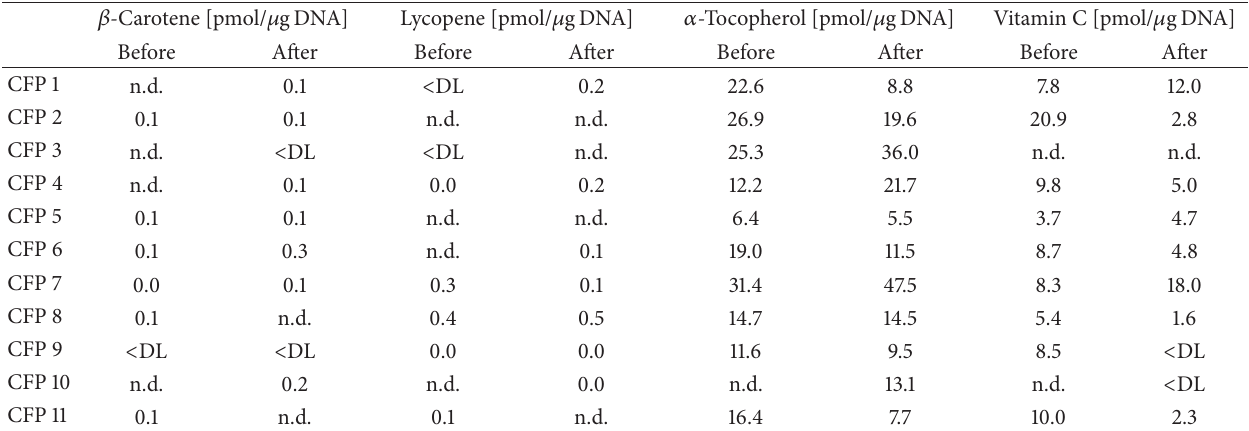
Table 2: Concentrations of 𝛽 -carotene, lycopene, 𝛼 -tocopherol, and vitamin C in buccal mucosa cells of 11CF patients. Results are given in pmol/ 𝜇 g DNA [ CFP: CF patient, < DL: below detection limit, n.d.: not detectable ] . 𝛽 -Carotene [ pmol/ 𝜇 gDNA ] Lycopene [ pmol/ 𝜇 gDNA ] 𝛼 -Tocopherol [ pmol/ 𝜇 g DNA ] Vitamin C [ pmol/ 𝜇 gDNA ] Before After Before After Before After Before